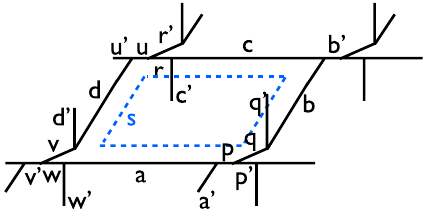
FIG. 5. Plaquette term in the Walker-Wang model (taken from Ref. [30]).